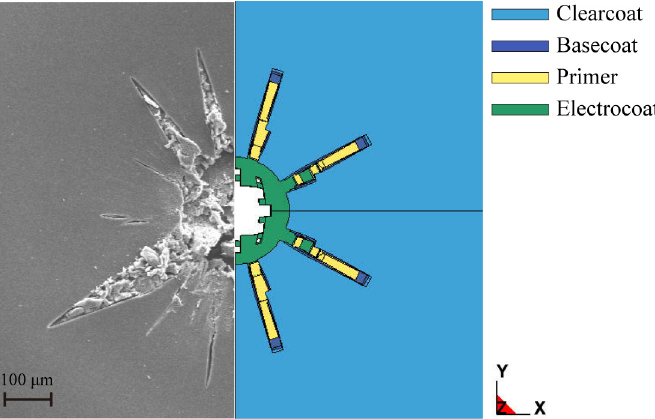
Figure 8. A comparison between the experimental (left) and simulated (right) polymer-ply damage patterns. The area displayed is a part of the finite element model.